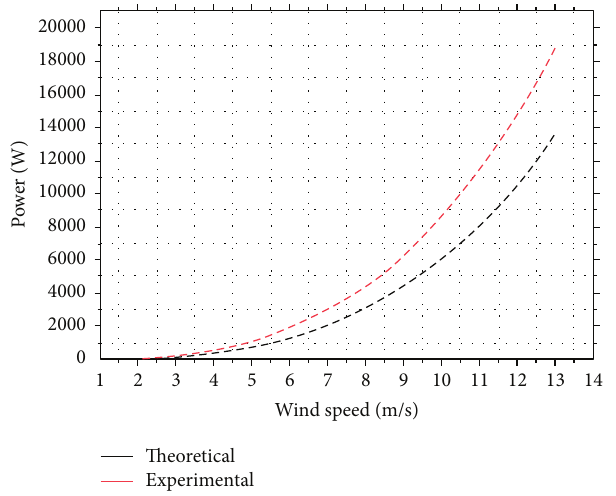
Figure 12: Power variation according to the wind speed. Compari- son between experimental and simulation